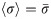
(a) The average number of links 〈σ〉 = ∂F/∂U and (b) the log-likelihood function W = F − U〈σ〉 showing that W assumes its maximal value when 〈σ〉=σ¯. (c) the fluctuation δU^. (solid-red line: females, solid-blue line: males).